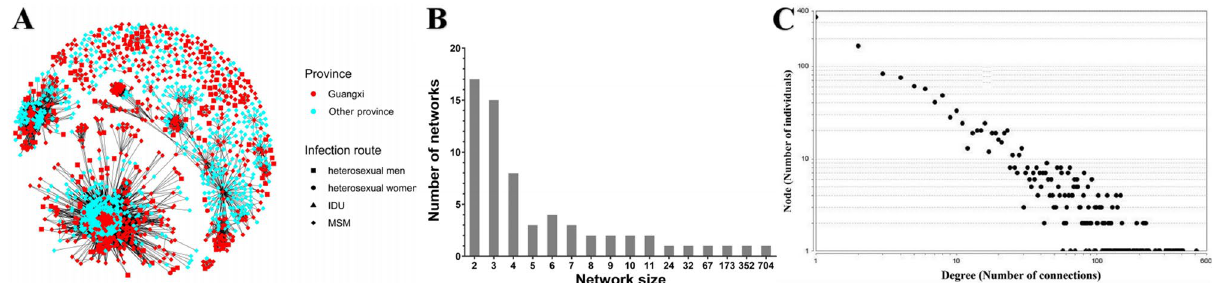
Figure 2. HIV-1 transmission clusters. The network was constructed using a custom R script with the network package in R version 4.0.2 software. ( A ) Infection route and region-associated transmission clusters. Different colours represent different provinces. Different shapes represent different infection routes: solid square: heterosexual men; solid circle: heterosexual women; solid triangle: IDU; solid diamond: MSM. ( B ) Size of HIV-1 transmission clusters among the MSM. ( C ) Distribution of HIV-1 transmission degree. Node represents individuals in the network; degree represents the number of edges that link one node to other nodes; size represents the number of individuals in a